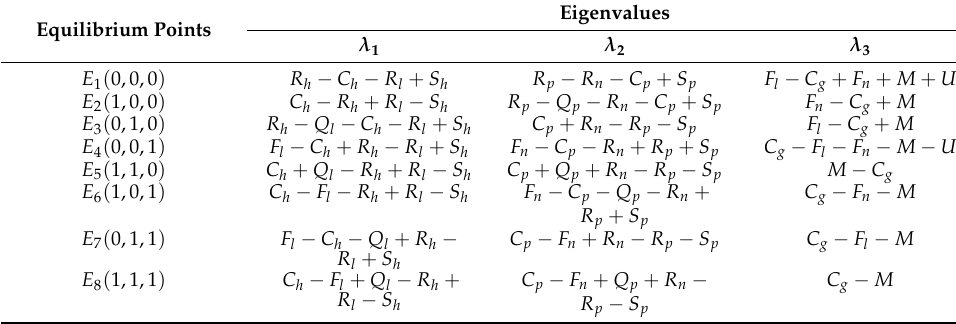
Table 2. Eigenvalue of Jacobian matrix.